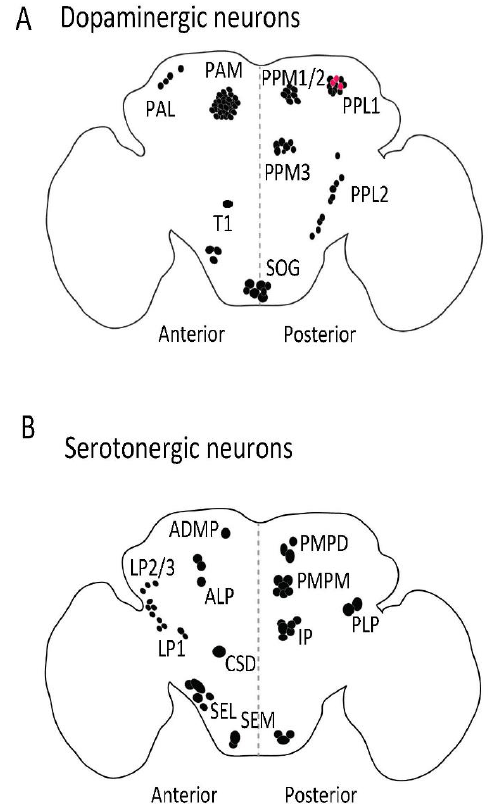
Figure 2. Distribution of dopaminergic ( A ) and serotonergic ( B ) neurons in adult fly brain. The dopaminergic and serotonergic neurons are distributed in various clusters in flies. Anti-TH antibody (Abcam, 128249, Cambridge, UK) was used to label dopaminergic neurons and serotonin transporter protein trap (bloomington stock no. 60529) was used to visualize serotonergic cell bodies in adult fly brain. PAM: Protocerebral anterior medial; PAL: Protocerebral anterior lateral; PPL: Posterior protocerebrum lateral; PPM: Protocerebral posterior medial; T1: Thoracic 1; SOG: Subesophagal ganglion; PLP: Posterior lateral protocerebrum; ADMP: Anterior dorsomedial protocerebrum; ALP: Anterior lateral protocerebrum; LP: Lateral protocerebrum; PMPM: Posterior medial posterior medial; SEL: Subesophageal lateral; CSD: Contralaterally projecting, serotonin-immunoreactive, deutocerebral; SEM: Medial subesophageal ganglion; PMPD: Posterior medial protocerebrum, dorsal; IP: Inferior medial protocerebral. Red dot: PPL1 dopaminergic neurones ( A ) that also produce serotonin. Black dot : Dopaminergic (A) and serotonergic (B) cell bodies. In mammals, the vesicular monoamine transporters (VMAT1/SLC18A1; VMAT2/SLC18A2) store newly synthesized dopamine, serotonin, and adrenaline/noradrenaline in synaptic vesicles and large dense core vesicles for their ensuing synaptic and extra-synaptic release [33]. Drosophila has only one vesicular monoamine transporter ( dVMAT ) gene, which produces two splice variants with distinct C-termini, dVMAT-A and dVMAT-B [34]: dVMAT-A is expressed in dopaminergic, octopaminergic, and serotonergic neurons [34]; in contrast, dVMAT-B is present in a small population of optic glia and plays role in histamine homeostasis [35]. There is no mammalian equivalent to glial expression of a VMAT isoform. The role of neuronal dVMAT-A is understood in considerable detail; in fact, the elaborate toolbox of Drosophila research allows for neuron-specific re-expression of dVMAT in a dVMAT-null background. Hence, it is possible to interrogate dVMAT-deficient flies to understand the redundancy and complementary function of the three monoamines [36]: Dopamine is, for instance, important in male courtship but it is redundant, because it can be replaced by octopaminergic signaling. The circadian rhythm, on the other hand, depends on the cooperation of